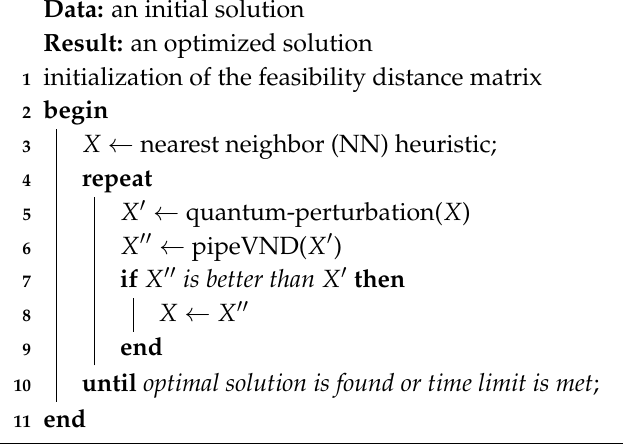
Algorithm 1: Pseudocode of the novel general variable neighborhood search (GVNS) Data: an initial